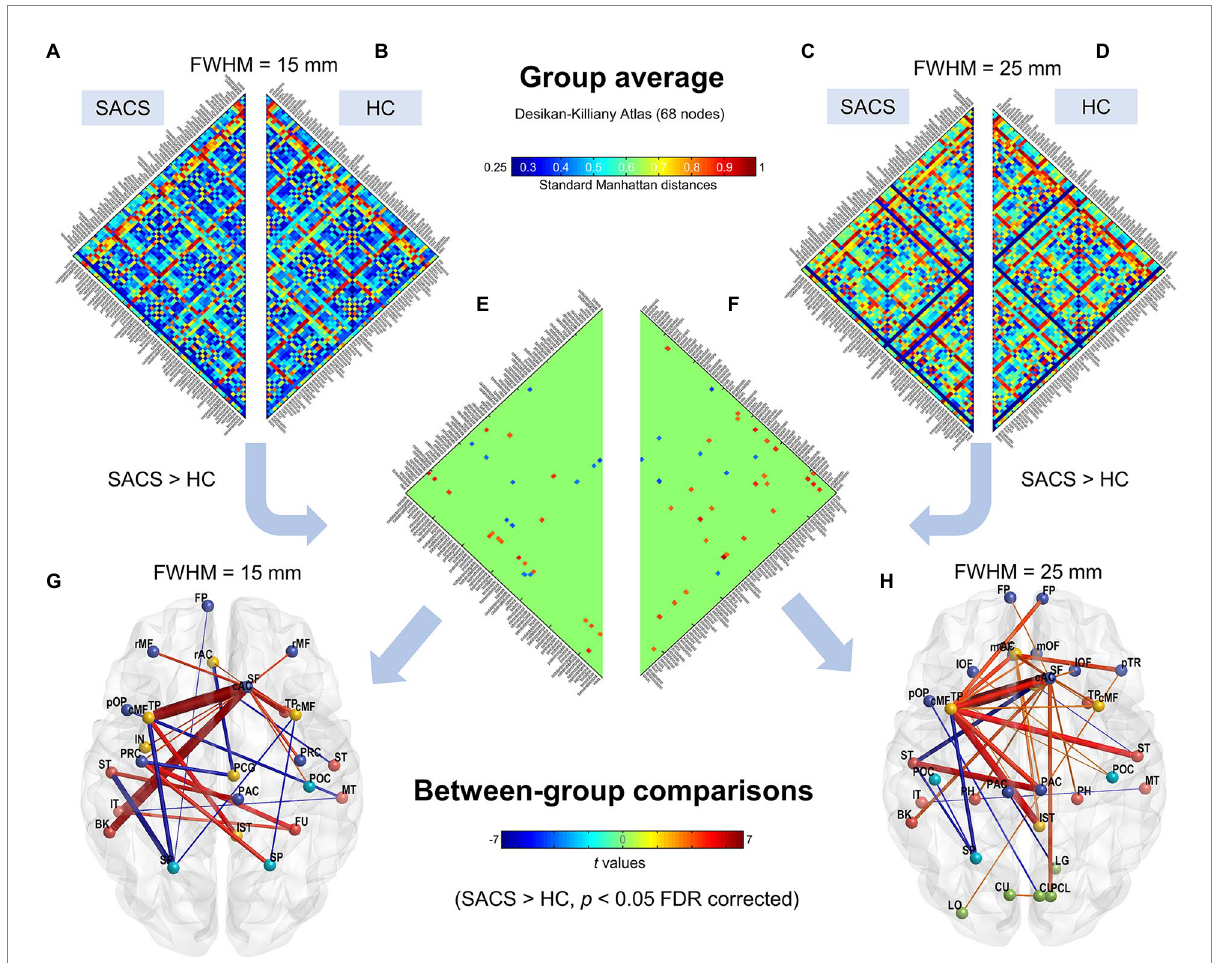
FIGURE 3 Subject-level network using the Desikan-Killiany atlas (68 parcels). Group average connectivity matrices for SACS patients (A,C) and healthy controls (B,D) with 15 mm and 25 mm smoothing kernels using the Desikan-Killiany atlas are shown. The colorbar shows standard Manhattan distances, with shorter values reflecting greater structural connectivity and vice versa. Subgraphs (E,F) show between-group differences on single- subject network connectivity with 15 mm and 25 mm smoothing kernels, respectively, which could be visualized as graphs. (G,H) The colorbar in the lower panel shows t values for the group statistics on edges, with a positive t -value representing that the SACS patients had a longer Manhattan distance and thus a lower structural connectivity on the edge, and vice versa. LH, left hemisphere; RH, right